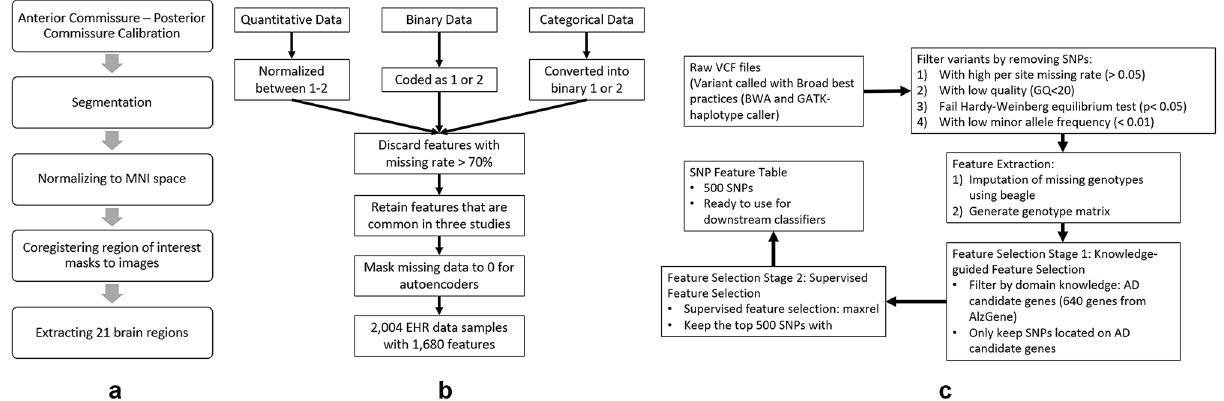
Figure 7. Data pre-processing pipeline for three data modalities: ( a ) Imaging data is first skull stripped, segmented into white matter, grey matter, and cerebrospinal fluid. Then the images are registered to a standard space, prior to extracting 21 brain regions using anatomical automatic labeling atlases. ( b ) Clinical data is normalized between 1–2 or encoded as 1–2. Then we discard features with values missing values > 70% to obtain 1680 features for 204 patients. ( c ) SNP data is first filtered, error corrected, feature selection using known genes and then followed by maximum relevance (maxrel) based methods, to obtain 500 SNPS for 808